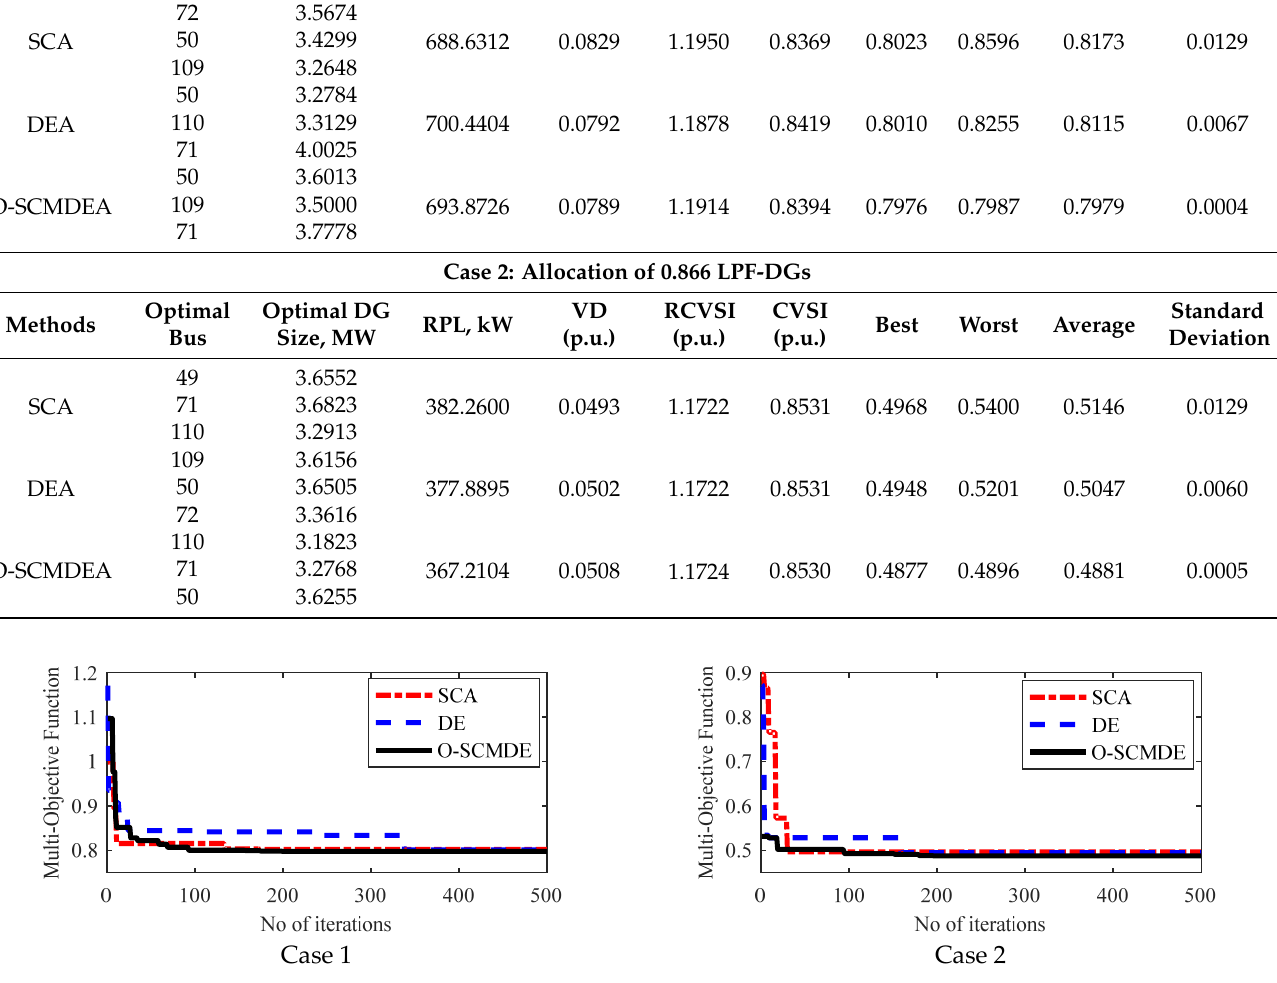
Figure 11. Comparison of the convergence characteristics of the SCA, DEA and O-SCMDEA for both cases of scenario IV of the 118 bus system.